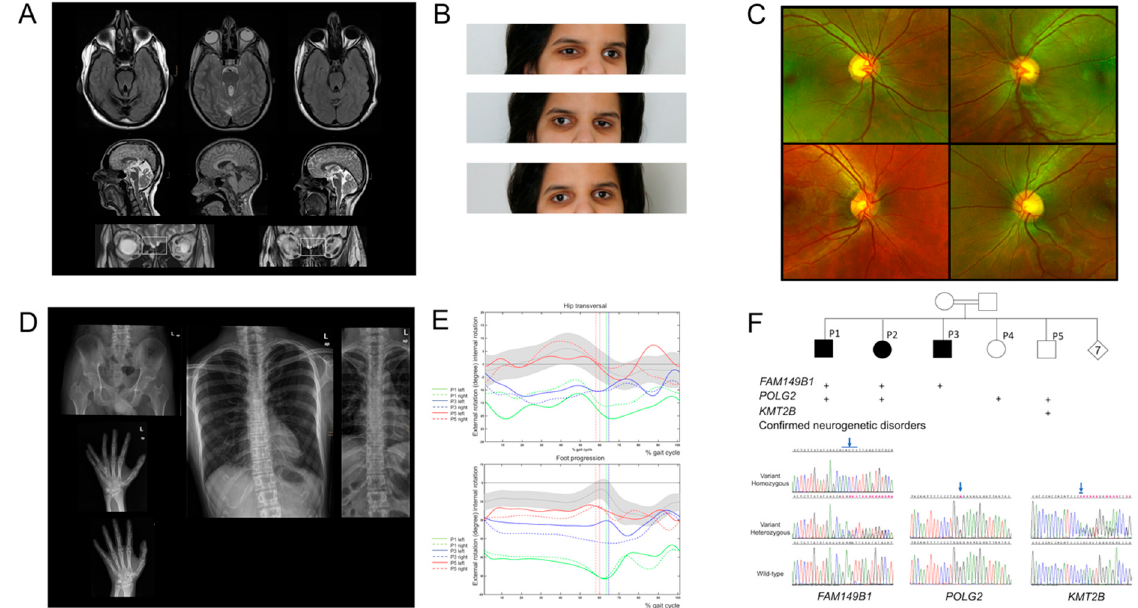
Figure 1. Clinical features in three siblings with biallelic FAM149B1 variants. ( A ): Brain MRI in P1, P2, P3 (left, middle, right column) with MTS (upper row), cerebellar hypoplasia of the upper vermis and callosal dysgenesis (middle row). Olfactory imaging (bottom row) with olfactory bulb aplasia in P1 (left box) versus normal olfactory bulb in P3 (right box). ( B ): Bilateral Duane syndrome during childhood with compensatory head tilt in P2: limited abduction of left eye with induced ptosis on adduction of right eye (upper panel) and limited abduction of the right eye with induced ptosis of left eye (middle panel). Normal palpebral fissures of both eyes in primary position (bottom panel). ( C ): Fundus photographs with situs inversus of retinal vessels in P2 (upper row) and situs solitus in a healthy control (lower row) for comparison. ( D ): Radiographic features of mild skeletal dysplasia and variable digital features. ( E ): Gait analysis with increased hip rotation by relative motion of the femur to the pelvis (upper panel) and increased external foot rotation by absolute motion of the foot to the walking direction (lower panel) in the transversal plane in P1, P3, and P5. Gray bands indicate the reference group (mean + 1 SD), Color coded vertical line splits the gait cycle into stand and swing phase. ( F ): Simplified pedigree with ciliopathy-affected individuals indicated by full symbols, and segregation analysis and sequence chromatograms for FAM149B1 , POLG2 , and KMT2B variants detected in the same family. “+”, “present”.